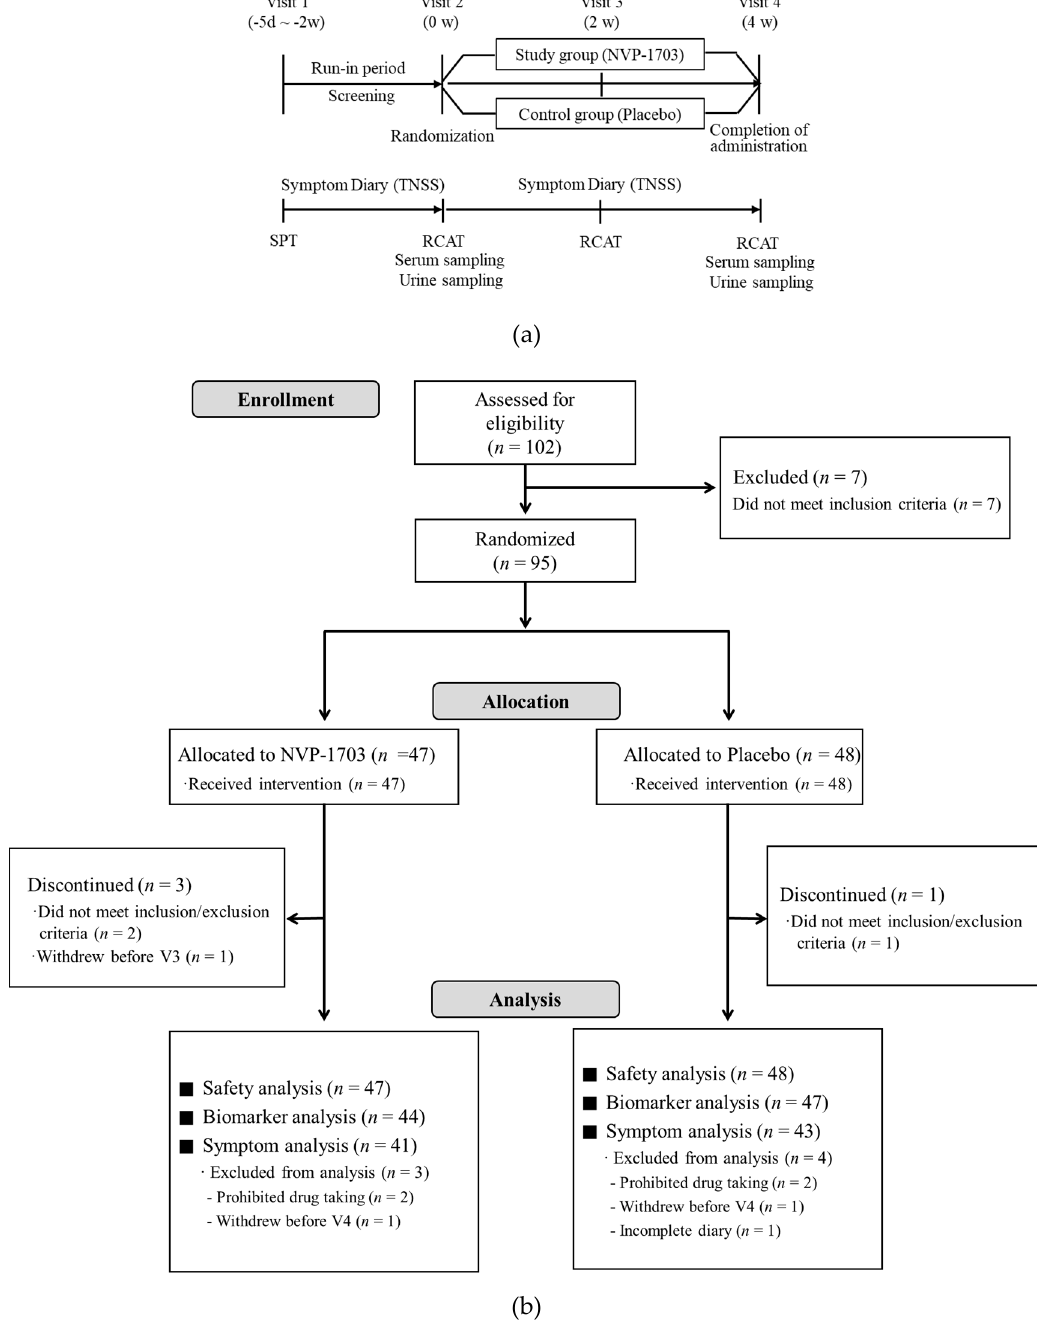
Figure 1. D escription of (a) study protocol and (b) flow diagram of subject disposition. TNSS, total Figure 1. Description of ( a ) study protocol and ( b ) flow diagram of subject disposition. TNSS, total nasal nasal symptom score; SPT, skin prick tests; RCAT, rhinitis control assessment test. symptom score; SPT, skin prick tests; RCAT, rhinitis control assessment